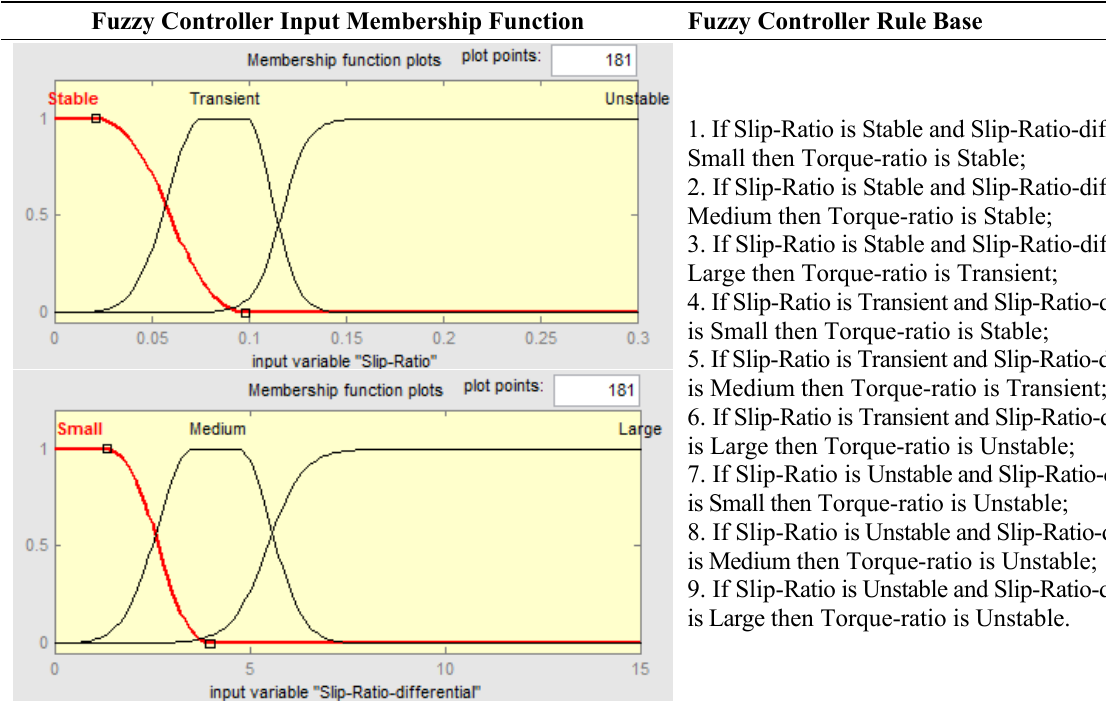
Figure 9. Relationship between slip ratio and friction coefficient. Table 4. Torque distribution strategy considering tire